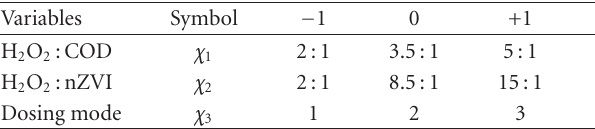
Table 2: Variable levels applied in the 2-level factorial design. Variables